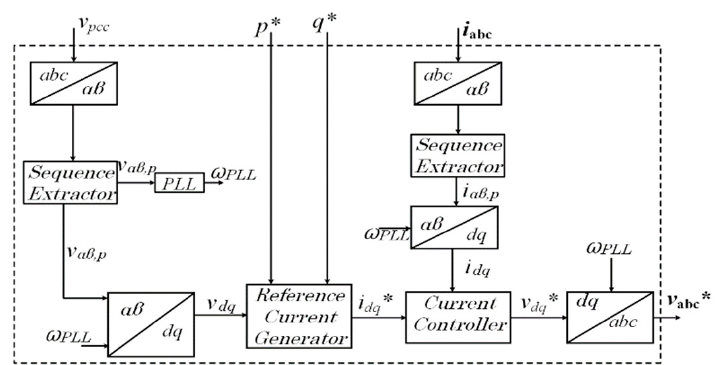
Figure 3. Conventional control scheme .